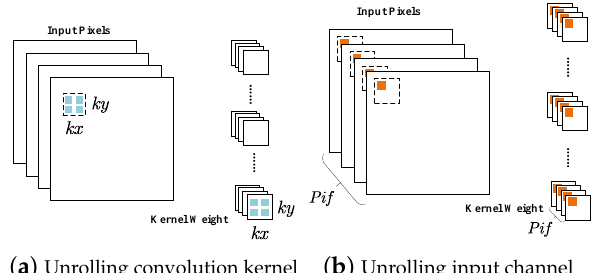
Figure 8. A demonstration of loop unrolling. ( a ) is the method of unrolling convolution kernel. The parallelism is developed according to the size of kernel. ( b ) explores the parallelism in the channels of the input